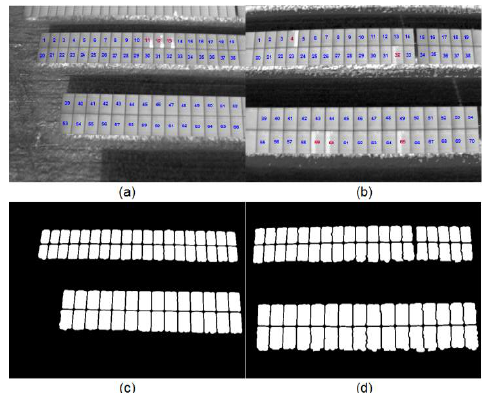
Figure 5. (a) and (b) Additional test images for evaluation of the fault diagnosis algorithm (www.kitawa.de), (c) and (d) Results of panel area extraction Figure 6 and 7 represent the results of algorithm implementation to the images in Figure 5 (a) and (b), respectively. The results of algorithm implementation on the two images were consistent with the defective panels Figure 3. Flow chart of fault diagnosis algorithm recognized by visual inspection, and no diagnosis error of recognizing a defective panel and a normal panel occurred. In Figure 6, the mean intensity of each panel was found to increase exponentially as the row in the same array advanced. Likewise, the mean intensities of normal panels generally showed a continuous pattern well-aligned with the adjacent panels in terms of mean intensity. These characteristics allowed us to each panel as the main parameter for fault diagnosis in the proposed algorithm. Table 1 outlines the results of performance evaluation using a confusion matrix on the basis of the number of panels inspected. The proposed algorithm recognized all defective panels displayed on the images. As presented in Table 1, FN is 0 in all three images, i.e., completeness is 100%,